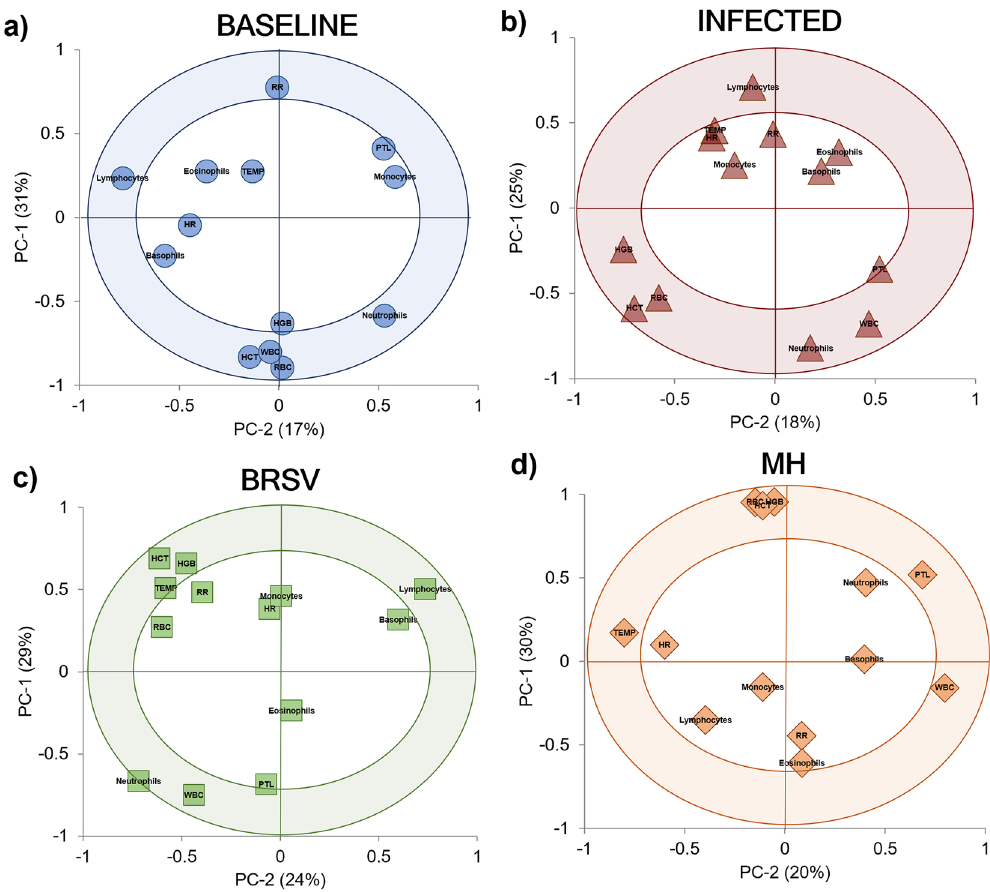
Figure 2. Principal component analysis (PCA) correlation loadings plots for TPR and CBC data. The variables inside the outer circle (colored area) have the most influence on database variability and are positively or negatively correlated within each model, while the parameters within the inner circle have low or no influence. ( a ) Baseline (n = 55); two PCs explained 48% of the variance. ( b ) General infection (V + B) database (n = 47) combined data from both studies, two PCs explained 43% of the variation of the database. ( c ) Infected with BRSV (n = 21), two PCs explained 53% of the variation of the database. ( d ) Infected with M. haemolytica (MH) (n = 26), two PCs explained 50% of the variation of the